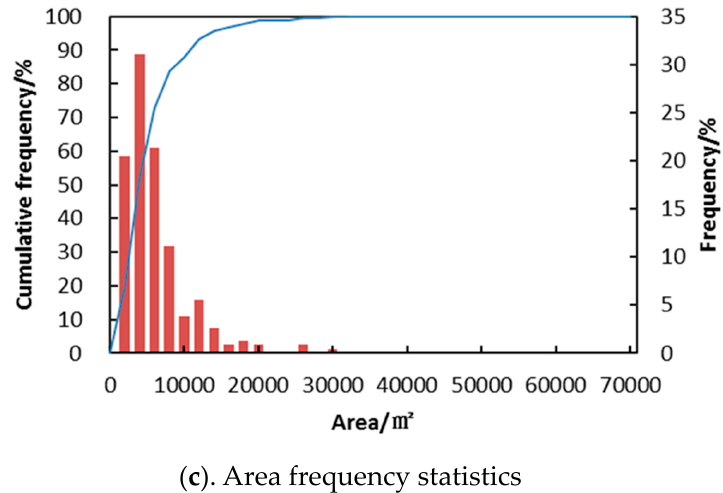
Figure 4. The geometrical statistics of historical rockfalls.